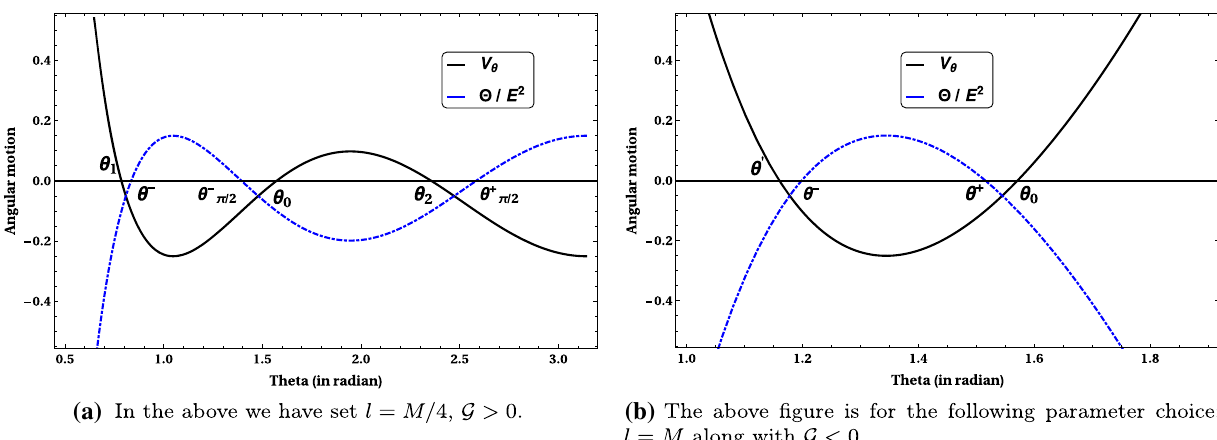
Fig. 10 We have presented the potential and momentum responsible for angular motion of a massless particle with L / E ≡ ξ = 0 . 5 M , a = M and λ = − M 2 /